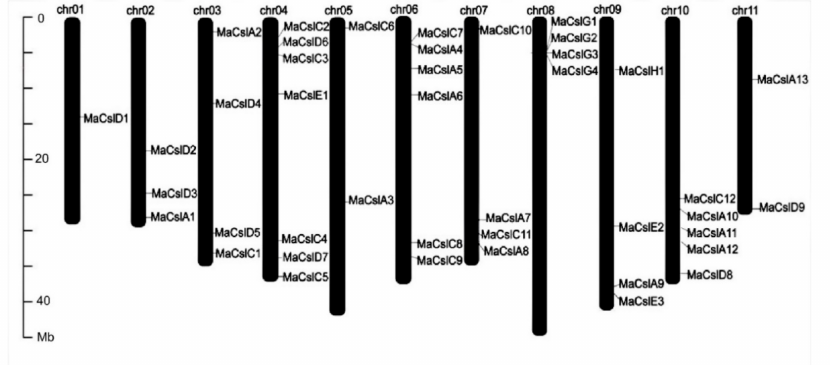
Figure 3. Chromosomal localization of the MaCsl genes in the banana ( Musa acuminata )